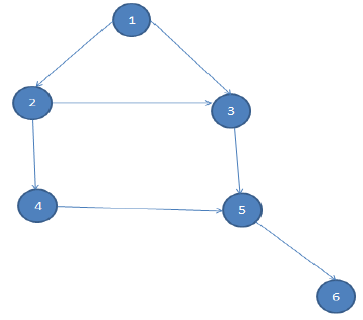
Figure 1. Proposed Network. Table 1. Notations.